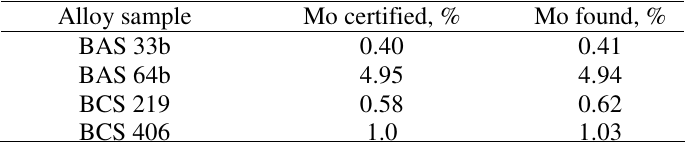
Table 7. Determination of Mo(VI) in alloy steel